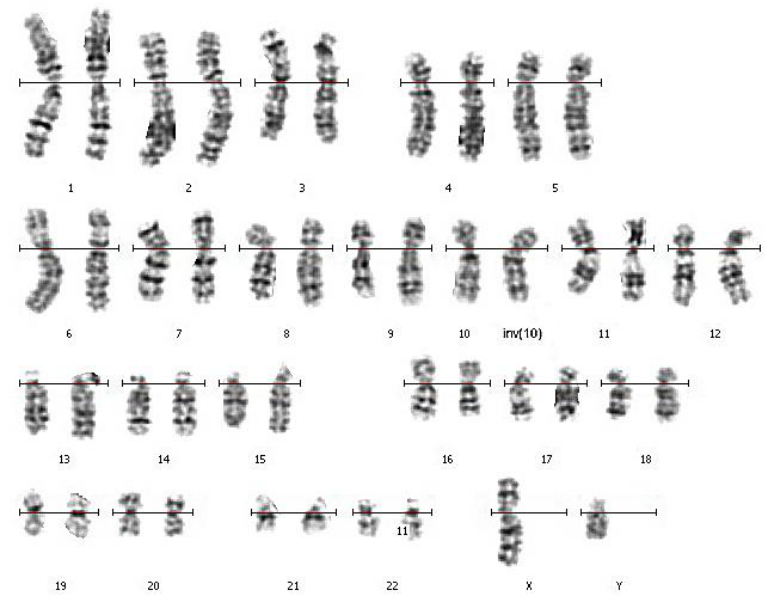
Figure 1. The patient’s GTG-banded chromosomes. The rearranged homolog of chromosome 10 is marked with